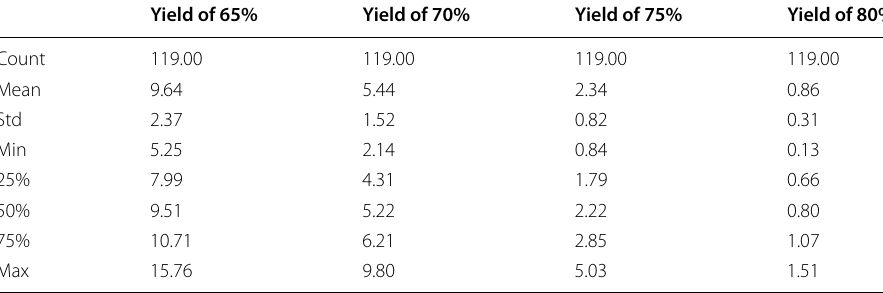
Table 3 Undiscounted option premiums basic